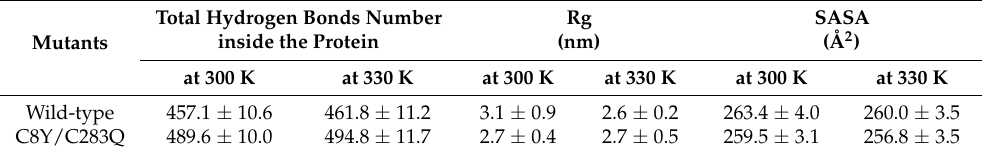
Table 4. Hydrogen bonds number, Rg and SASA values of wild-type and mutant C8Y/C283Q. Total Hydrogen Bonds Number inside the Mutants